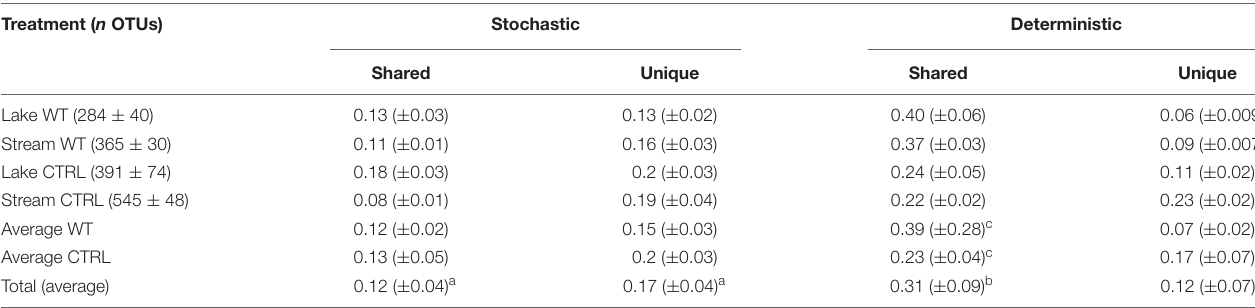
TABLE 2 | Abundances of OTUs in the different treatments (means ± one standard deviation) and proportions of OTUs (means ± one standard error) that were only present in one biological replicate (“stochastic”) or in all the three biological replicates (“deterministic”). Treatment ( n OTUs)